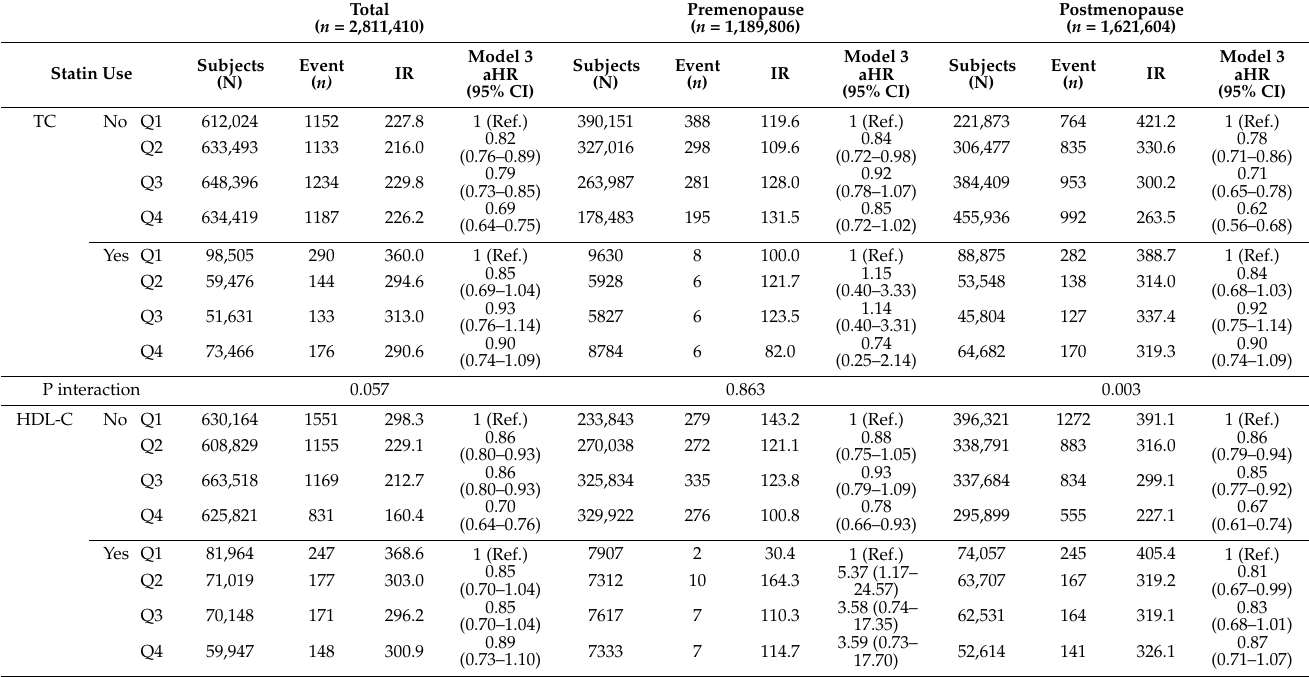
Table 4. Risk of hematologic malignancy by quartile of each lipid profile according to statin use and menopausal